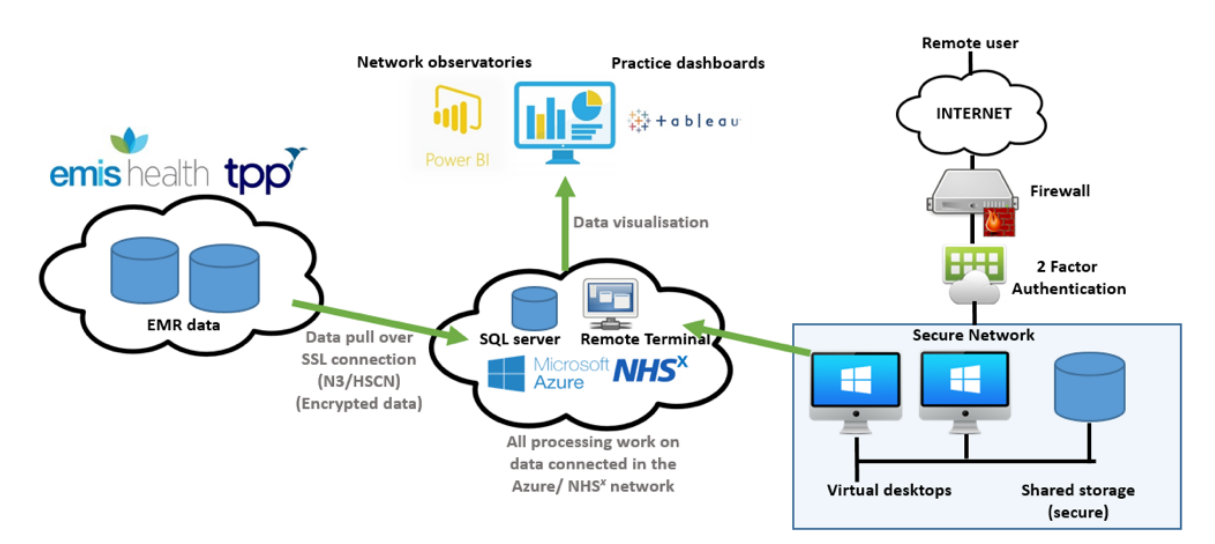
Figure 2. Flow of data for clinical trials in the ORCHID